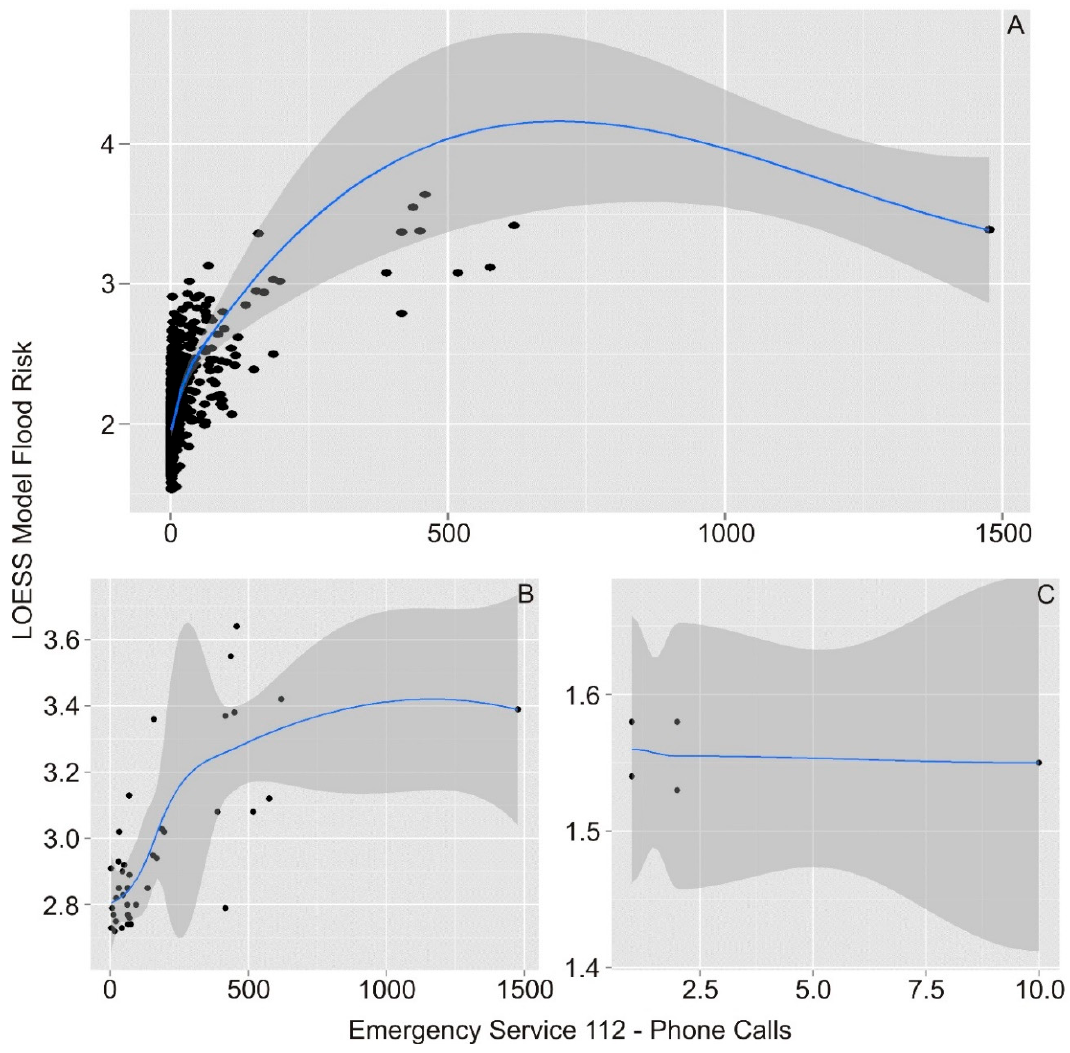
Figure 6. Locally estimated scatterplot smoothing (LOESS) model fits for flood risk values vs. phone calls number (Emergency Service 112) for all flood risk classes ( A ), flood risk class A ( B ), and flood risk class C ( C ). Flood risk classes are from PRICAM project results.